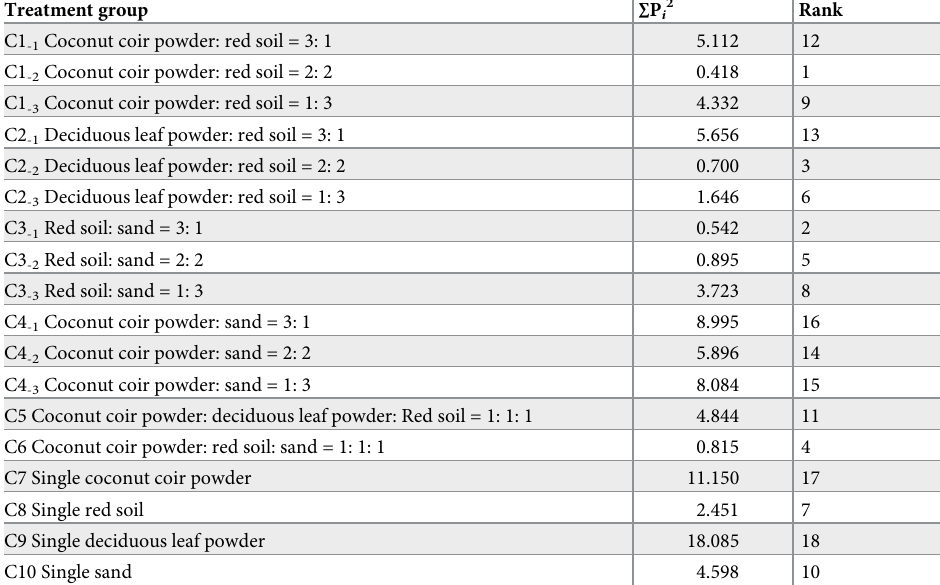
Table 6. Comprehensive evaluation of different substrate combinations and proportions via multi-vector coordinates. Treatment